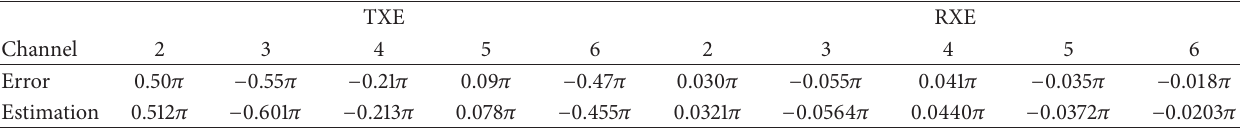
Table 2: The phase errors added and